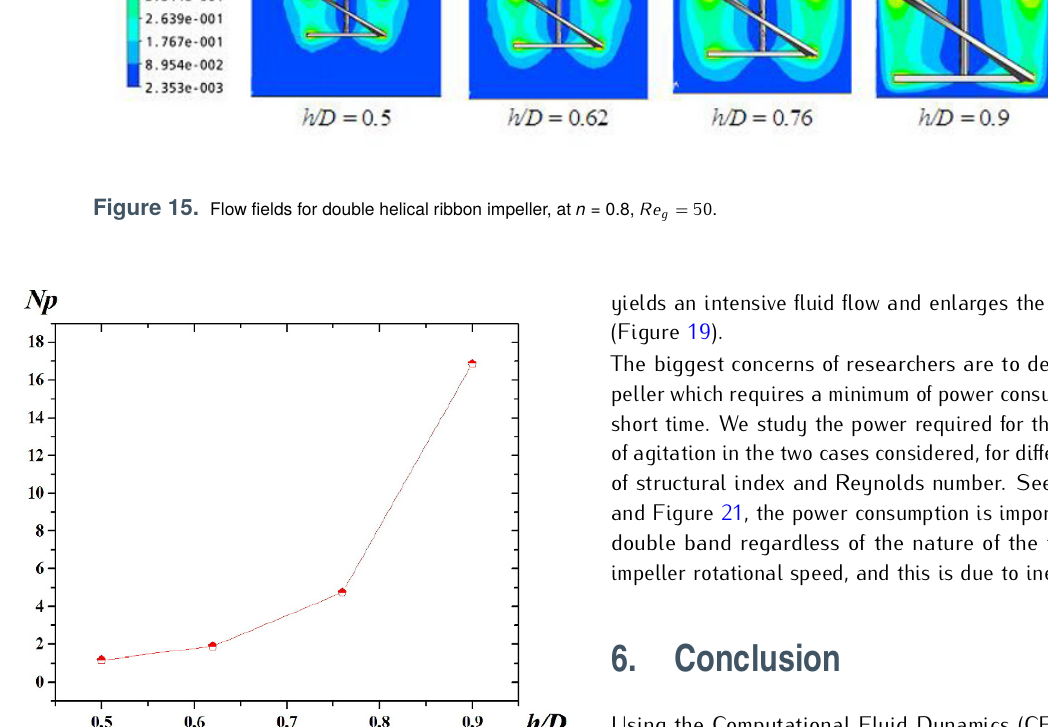
Figure 16. Power number for double helical ribbon impeller, n = 0.7, Re g = 50 .